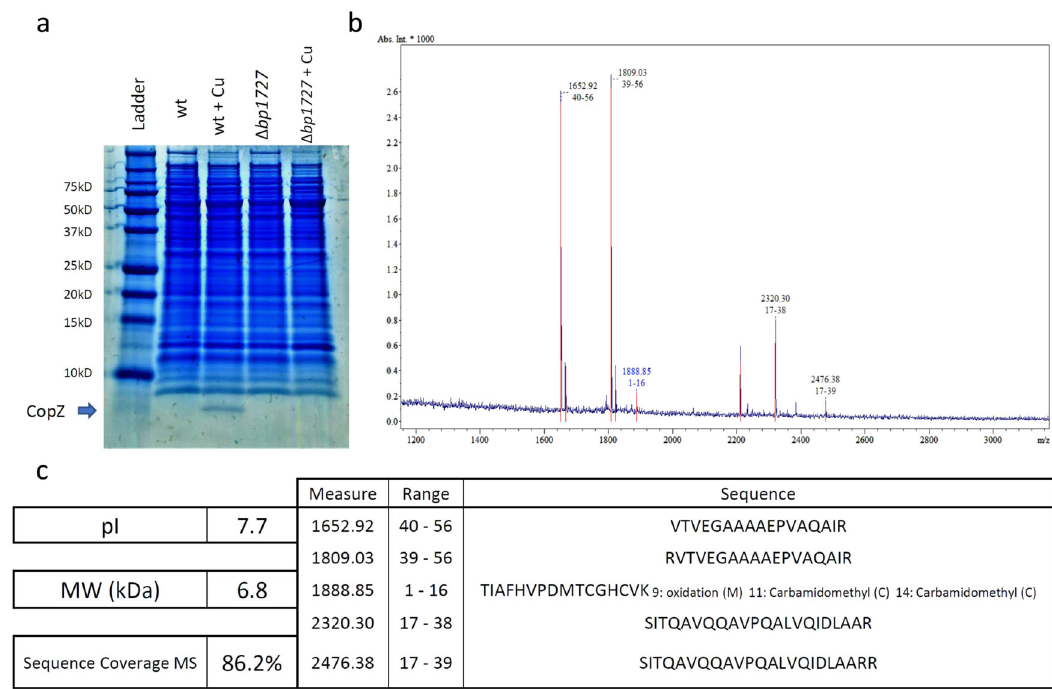
Fig. 3 Identi fi cation of CopZ in B. pertussis . a Lysates of wild type B. pertussis (wt) or the deletion mutant ( Δ bp1727 ) grown in SS medium supplemented ( + Cu) or not with 2 mM CuSO 4 were subjected to SDS-PAGE electrophoresis in Tris-tricine gels for the detection of CopZ. The gel was stained with colloidal Coomassie blue dye. CopZ migrates below the 10 kDa band of the markers. b , c The protein band was cut from the gel, and CopZ was identi fi ed by mass fi ngerprinting analyses. The m/z ratios of the peptides identi fi ed by MALDI-TOF are shown in panel b, and the sequences of the peptides are in c . This experiment complements the proteomic analyses, because the small size of CopZ hampered its detection in global proteomic approaches (see Fig. 2b and Supplementary Data